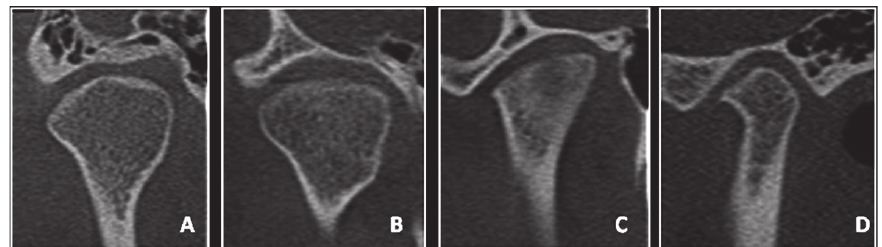
Figure 1- Cone-beam computed tomography images of temporomandibular joint showing morphological variation of the mandibular condyle. A- Normal (coronal view); B- Flattening (coronal view); C- Erosion (coronal view); and, D- Osteophyte (sagittal view)